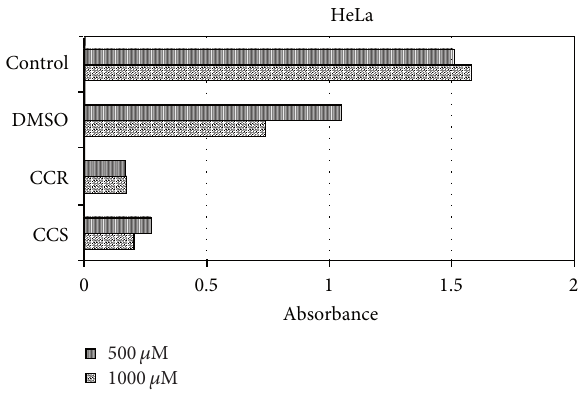
F4: Antiproliferativeeffect ofCCS